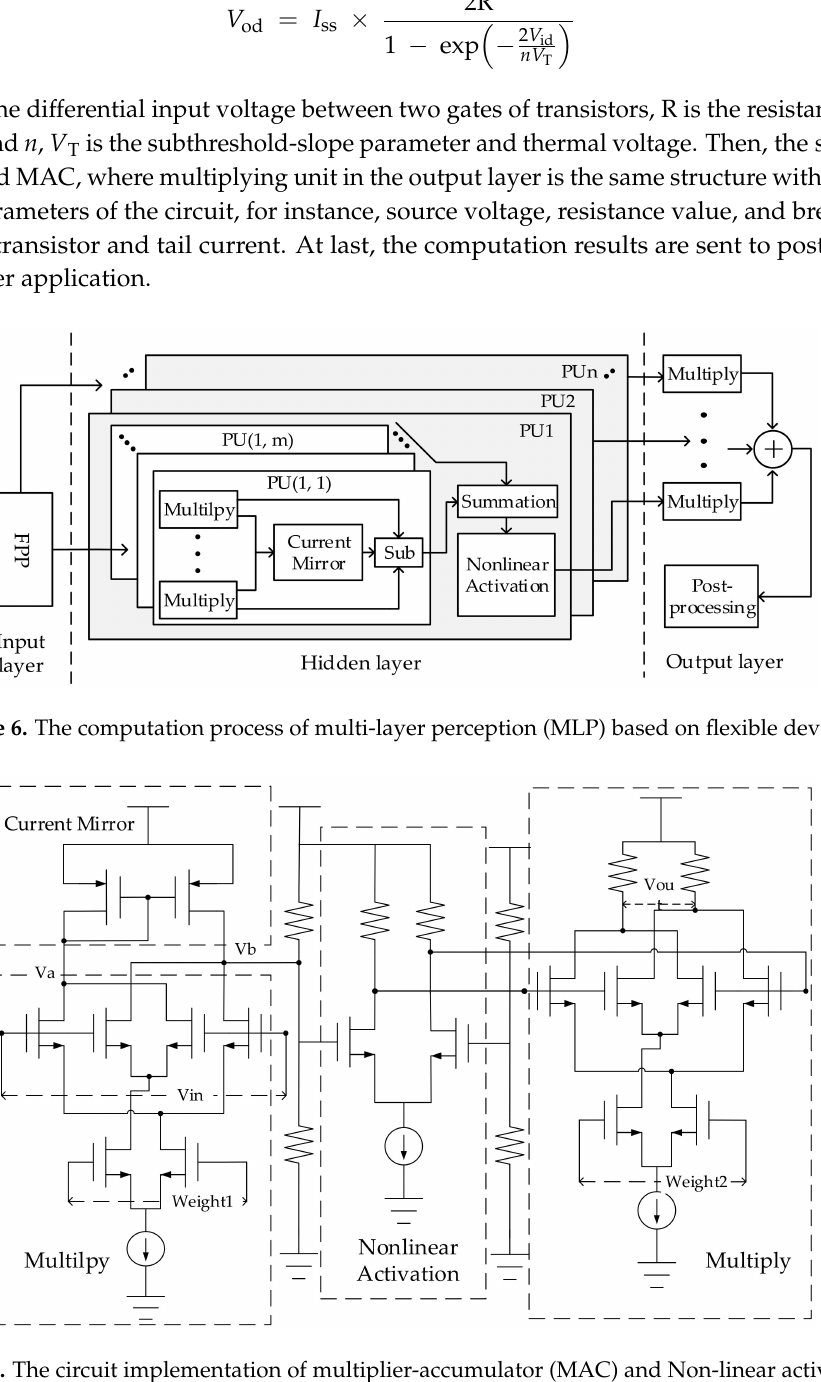
Figure 7. The circuit implementation of multiplier-accumulator (MAC) and Non-linear